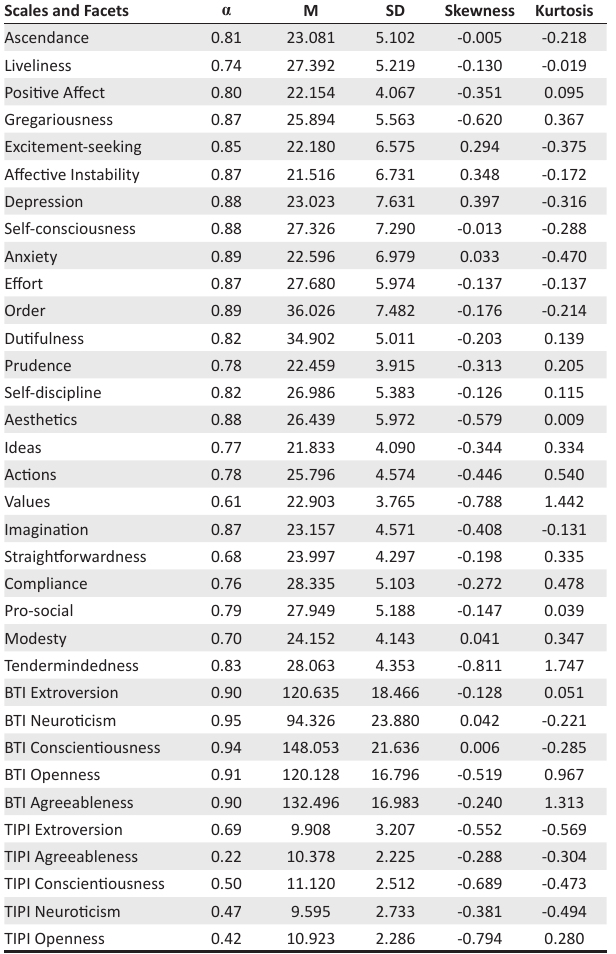
TABLE 1: Descriptive statistics of the BTI and TIPI scales and facets. Scales and Facets